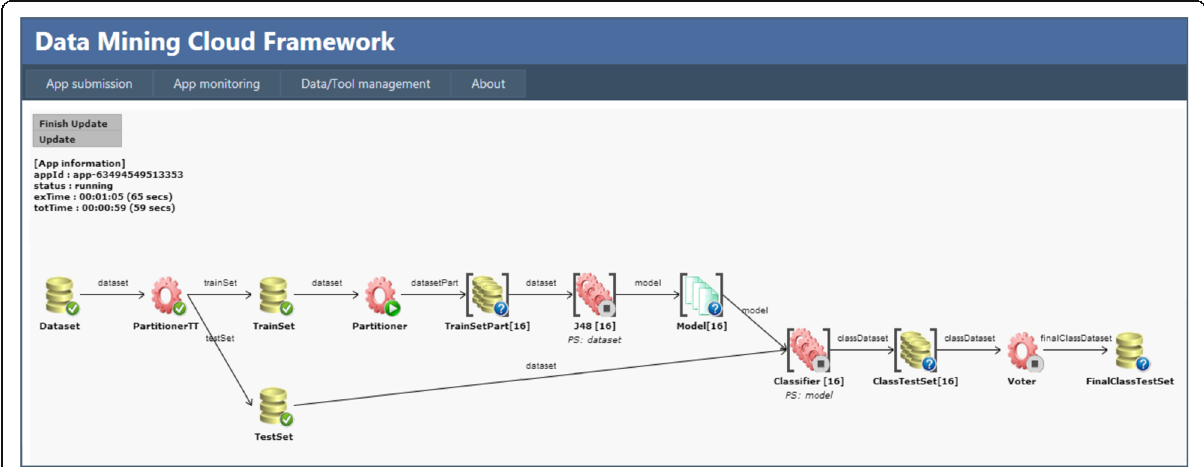
Fig. 2 A parallel classification workflow designed by the VL4Cloud programming interface. The figure shows a workflow designed by the VL4Cloud programming interface during its execution. The workflow implements a parallel classification application. Tasks/services included in square bracket are executed in parallel. The results produced by classifiers are selected by a voter task that produces the final